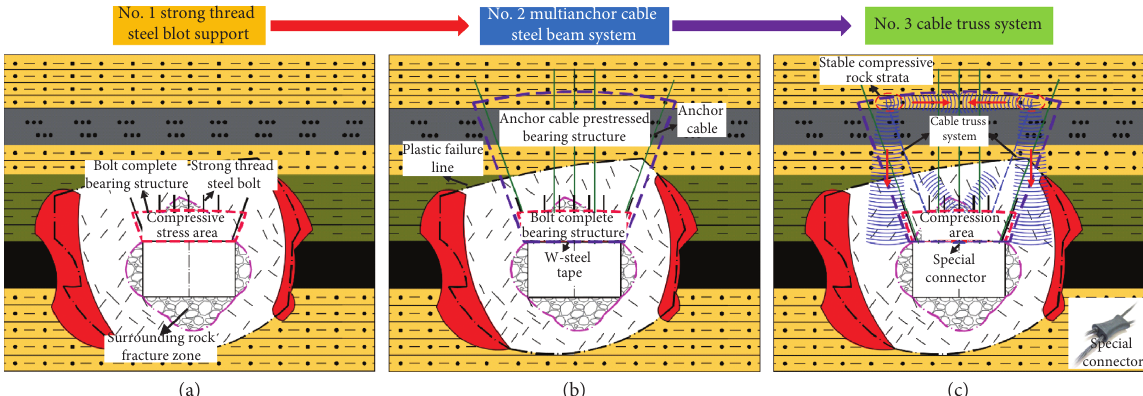
Figure 13: Principle of roof highly prestressed strong supporting roof system. (a) Strong bolt system. (b) Multianchor cable-steel beam system. (c) High prestressed anchor cable truss system.